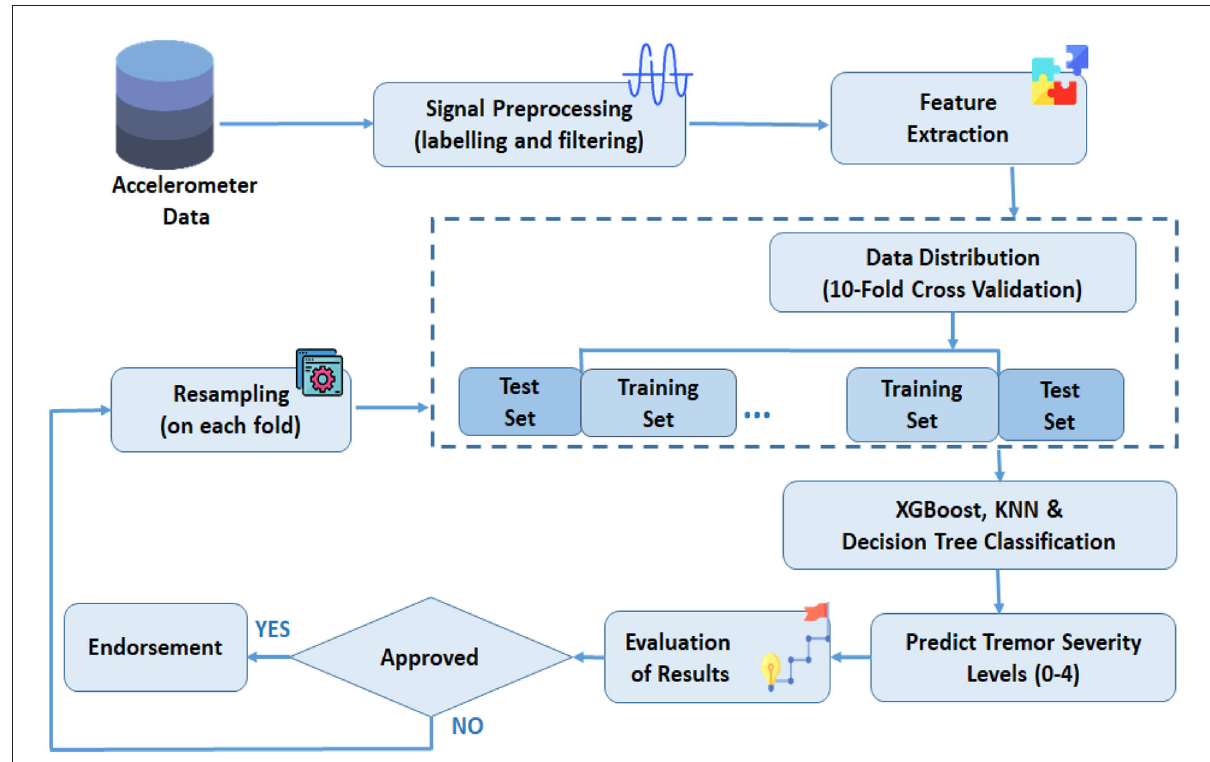
FIGURE1 The proposed framework for tremor severity